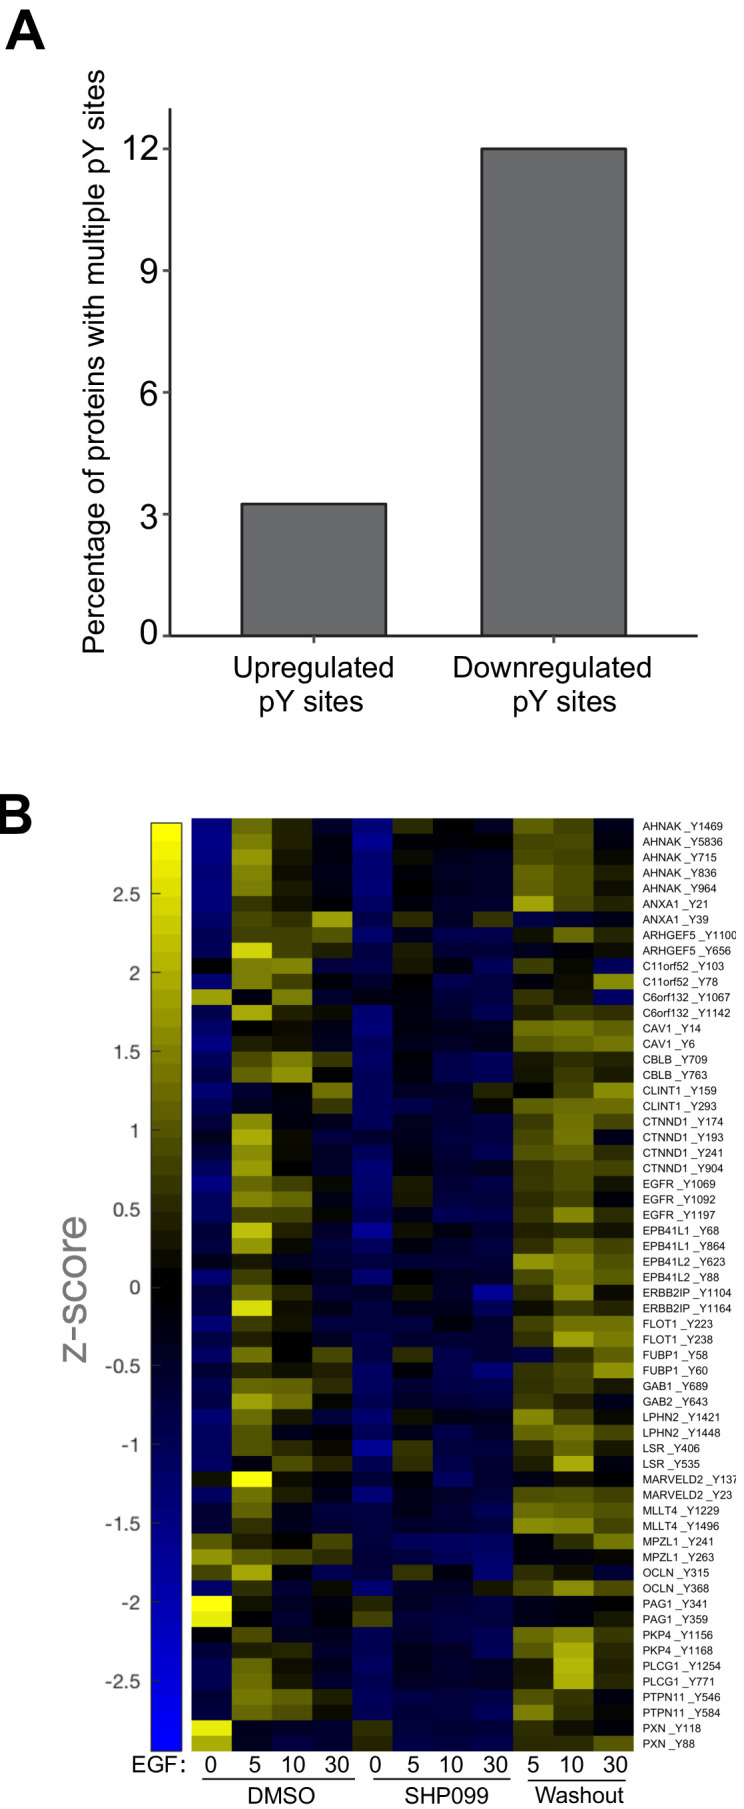
Proteins with SHP2-protected pY sites are enriched for multisite protein phosphorylation.(A) Quantification showing the relative percentages of proteins displaying multisite phosphorylation in SHP099-responsive pY sites. (B) Heatmap visualization of multisite protein phosphorylation dynamics in the class of SHP2-protected pY sites.Figure 7—figure supplement 1—source data 1.Table showing TMT relative abundance values for all SHP2-protected pY sites displaying multisite protein phosphorylation dynamics.